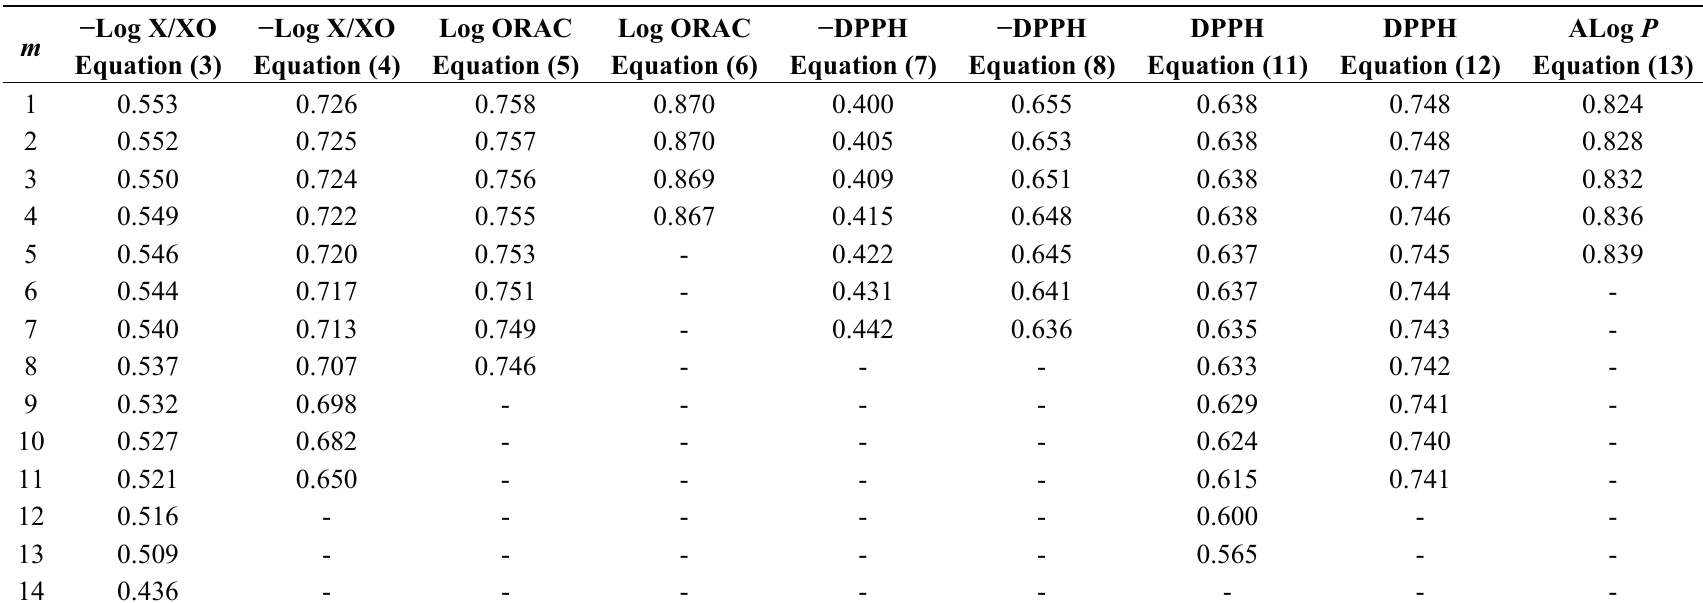
Table 3. Cross-validation correlation coefficient in a leave -m- out procedure for isoflavonoids.